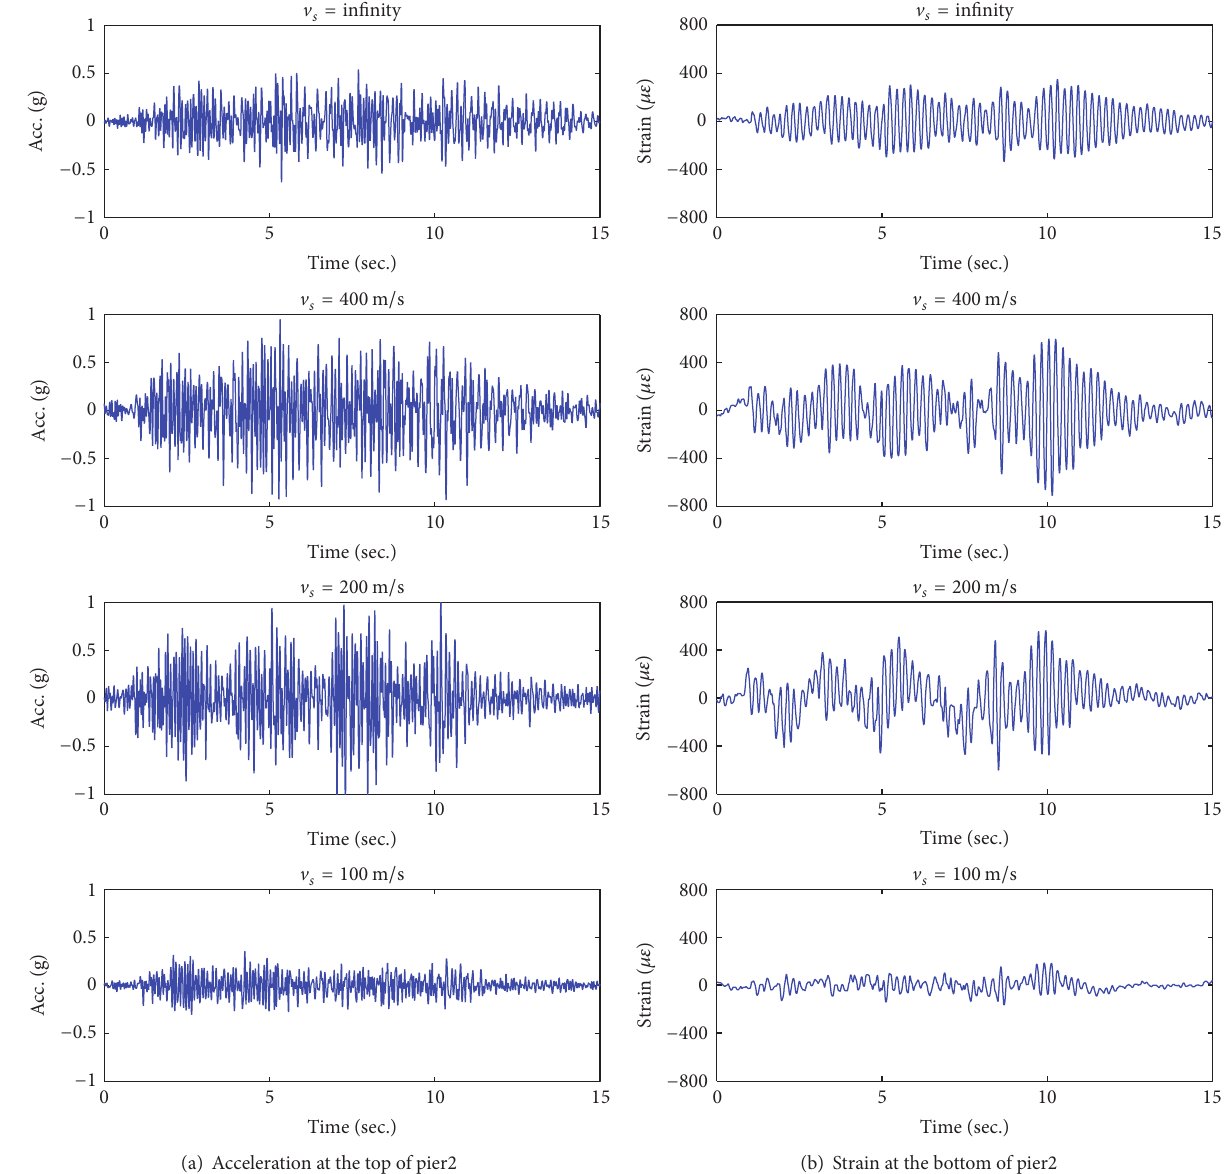
(b) Strain at the bottom of pier2